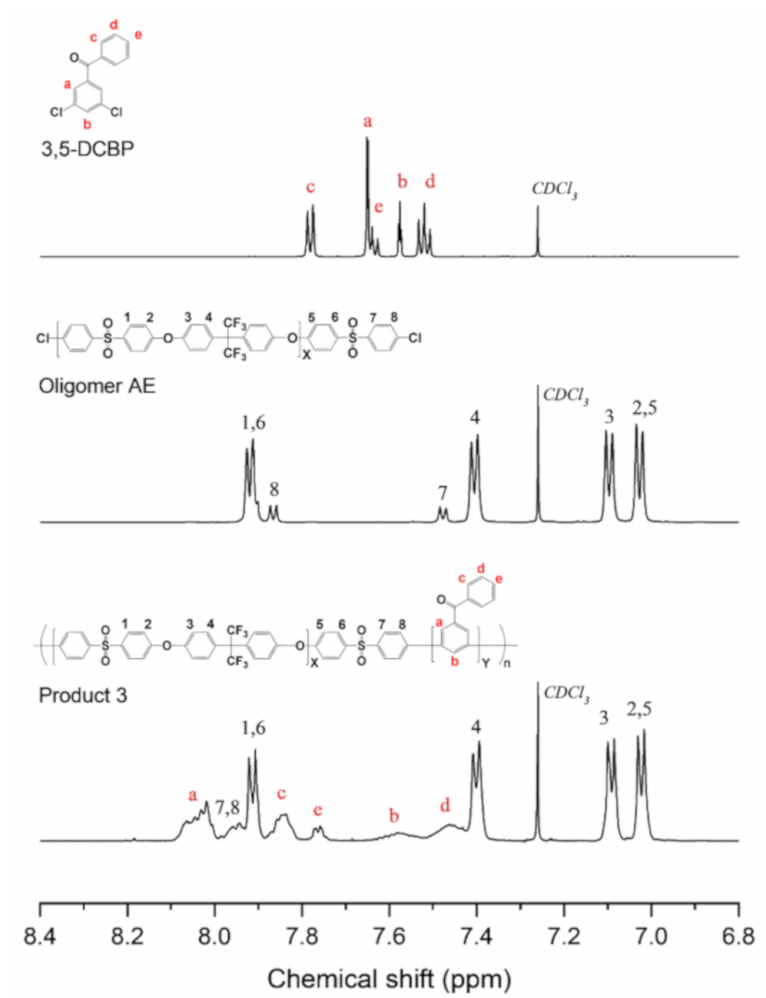
Figure 5. 1 H NMR of 3,5-DCBP, Oligomer AE, and Product 3 synthesized using Ni(COD) 2 .